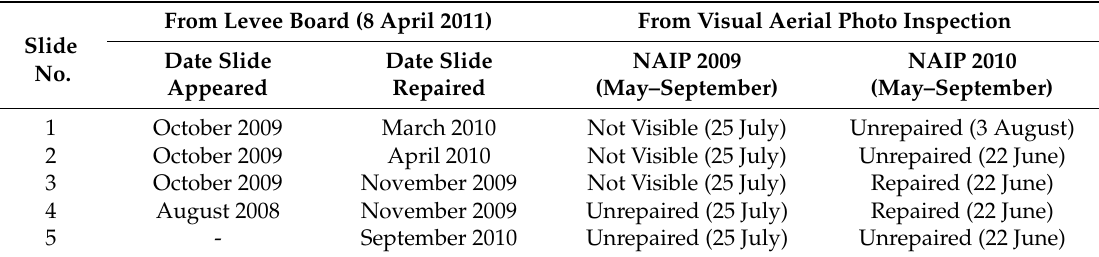
Table 2. Updated slides ground truth from the Mississippi Levee